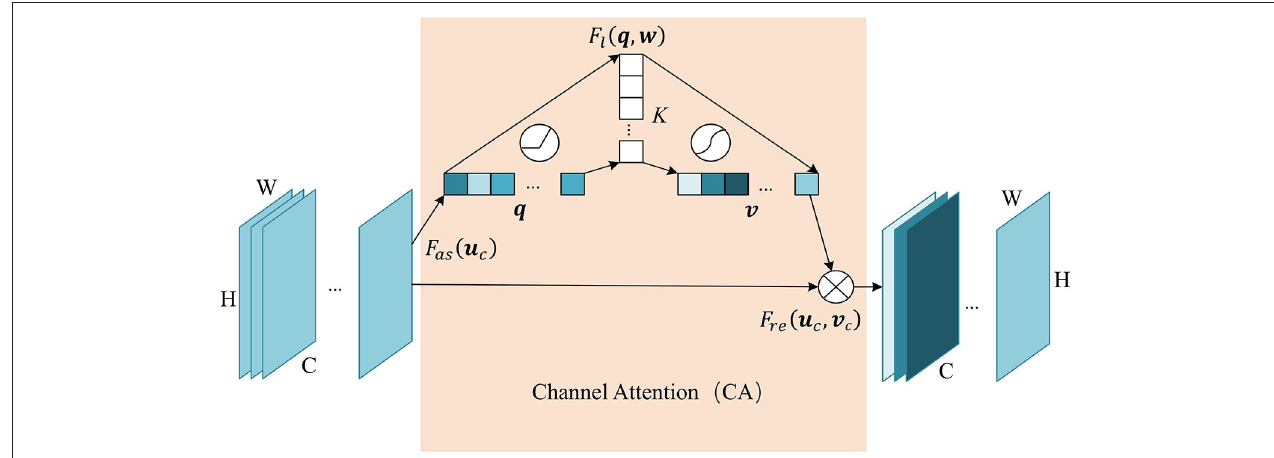
FIGURE 3 | The structure of Channel Attention (CA) module. The aggregate function F as generates a channel descriptor q ∈ R C . Self-learning function F l implemented by two fully connected layers generates the channel weights map v ∈ R C . Finally, function F re uses v to generate the output of the CA